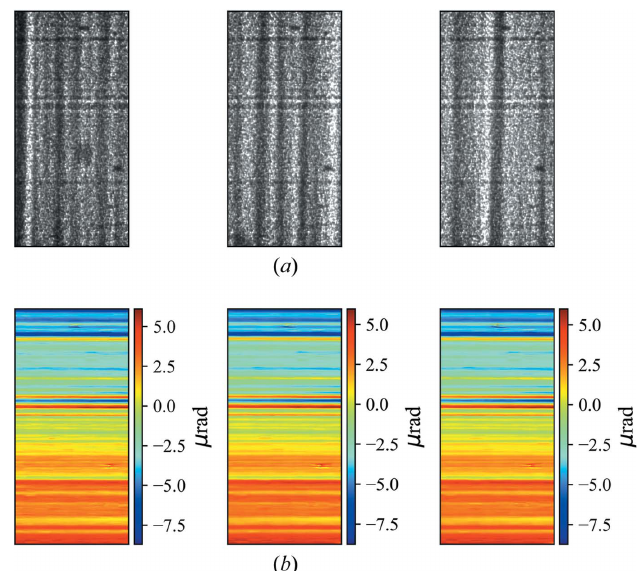
Figure 5 ( a ) Raw speckle images at three different positions of the DMM. These images have been rotated by 90 (cid:4) . The pattern of vertical stripes from the multilayer structure of the monochromator varies between each position providing three different incident wavefronts. ( b ) The corresponding calculated 2D maps of the wavefront slope error showing no obvious variation between them. The horizontally reflecting setup of the mirror being tested decouples the strong vertical variations derived from the